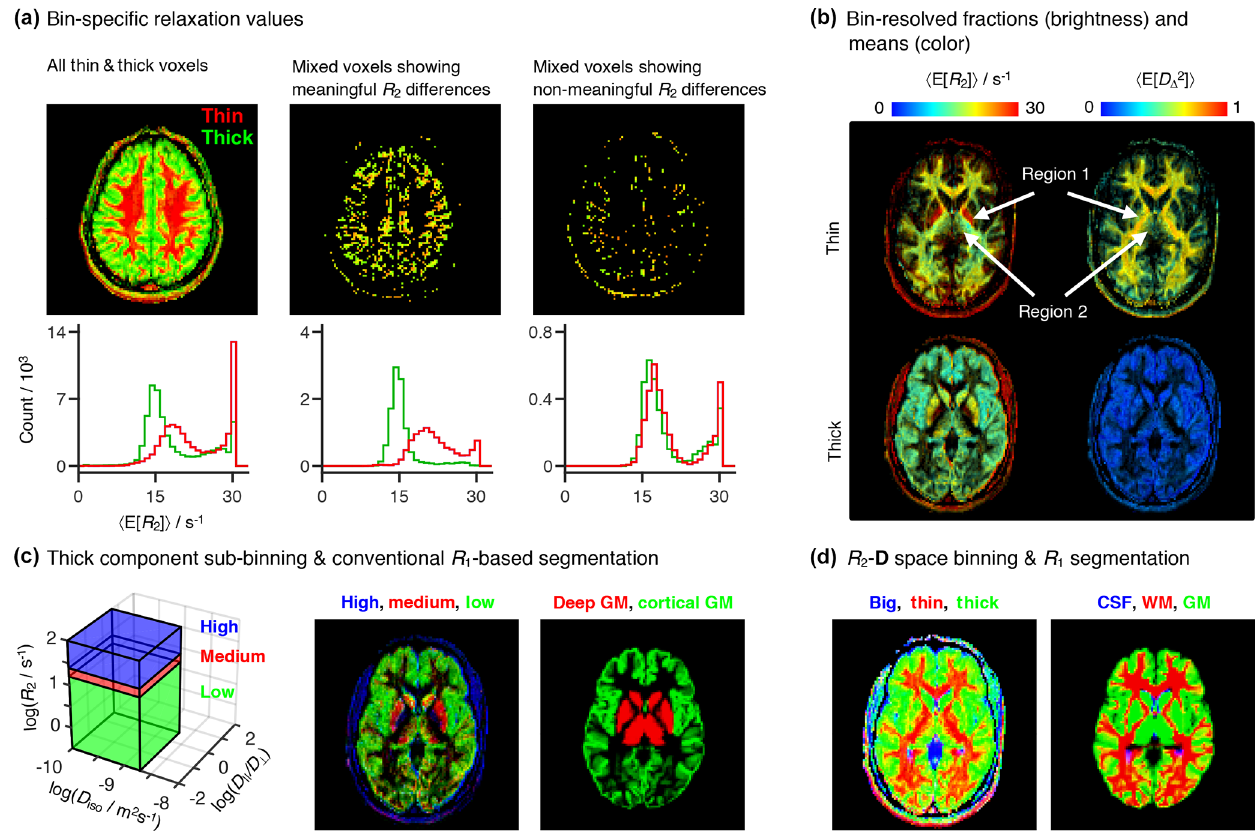
Figure 6. Per-bin relaxation properties and tissue composition. (a) Transverse relaxation properties specific to each of the “thin” (red) and “thick” (green) bins defined in Fig. 4a. The color-coded composite images (top) and histograms (bottom) display the fractional populations and average mean transverse relaxation values (cid:104) E [ R 2 ](cid:105) of the two bins. The first column displays all of the thin and thick voxels, while the two other columns focus on thin + thick mixtures wherein the bin-specific (cid:104) E [ R 2 ](cid:105) values exhibit either significant (second column) or nonsignificant (third column) differences. (b) Bin-resolved signal fractions (brightness) and average per-bin means (color) of R 2 , and squared anisotropy D (cid:49) 2 . Regions 1 and 2 identify microstructural properties singled-out in the Results section. (c) Subdivision of the thick bin into three different R 2 subspaces. The contributions from different sub-bins are compared with a high-resolution R 1 -weighted image segmented into four different tissues: white matter WM, cortical gray matter (GM), deep GM, and cerebrospinal fluid (CSF). Additive color maps display the spatial distribution of sub-bin fractions (from low to high R 2 : green, red, blue), and of cortical (green) and deep (red) GM. (d) Color-coded composite images showing the contributions of different bins (red = thin, green = thick, blue = big) and conventional R 1 -based segmentation labels (red = WM, green = cortical + deep GM, blue = CSF).